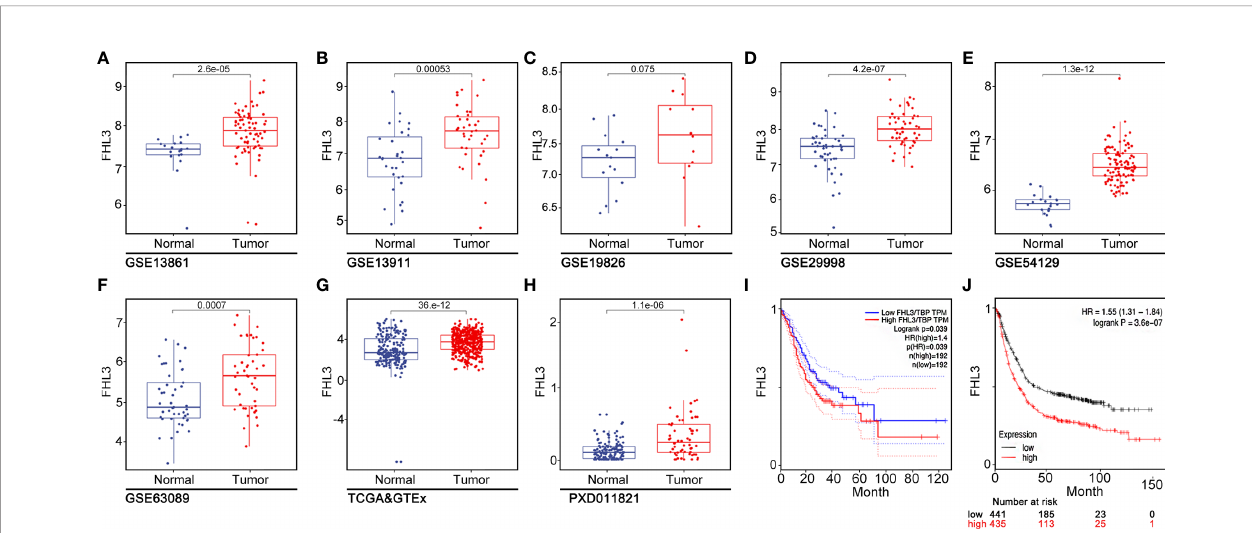
FIGURE 1 | FHL3 is an independent risk factor in gastric cancer. (1) The expression level of FHL3 in gastric cancer and its adjacent tissues was analyzed in TCGA database, GTEx, and Beijing dataset (A – H) ; the results suggested that FHL3 is highly expressed in tumor tissues. (2) The relationship between FHL3 expression level and prognosis is performed by Kaplan – Meier analysis in TCGA, KM-plotter cohorts; the results suggested that FHL3 is a prognostic indicator in gastric cancer; FHL3 overexpression always means poor overall survival (I, J)